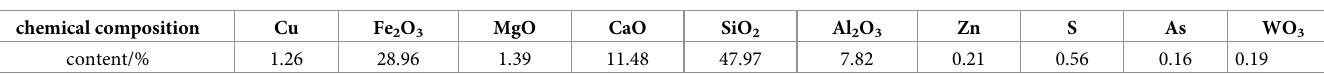
Table 1. Chemical contents of ore. chemical